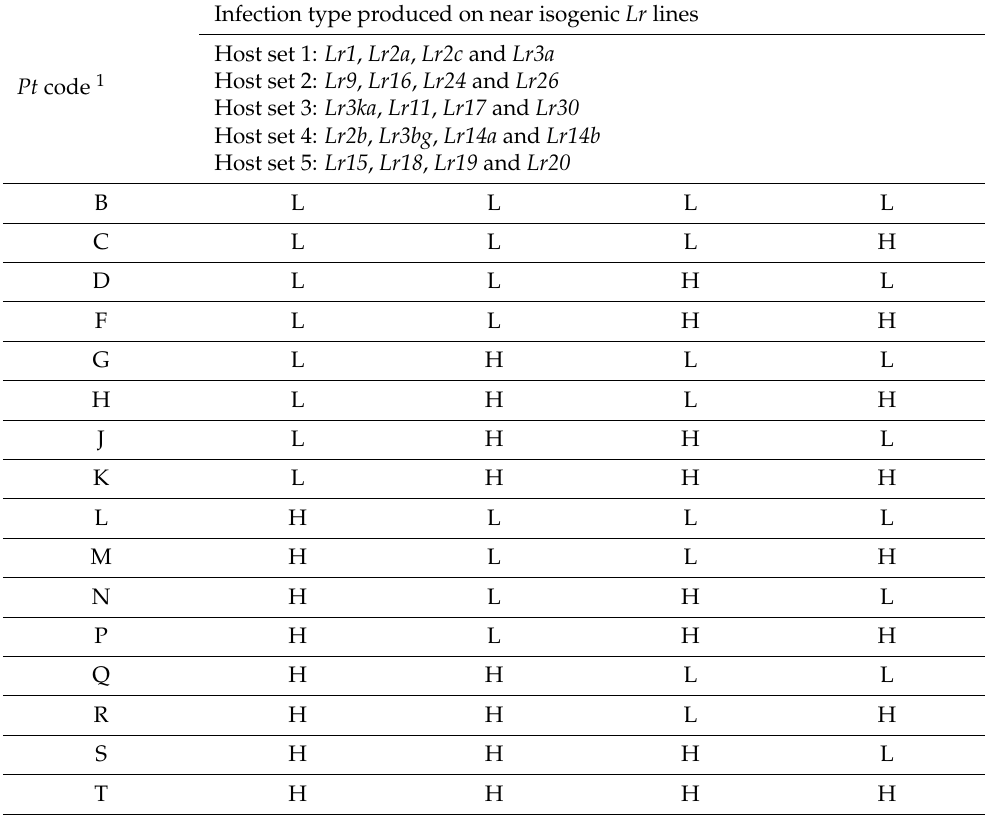
Table 1. Code for the 20 differential hosts for Puccinia triticina ( Pt ). Infection type produced on near isogenic Lr lines Host set 1: Lr1 , Lr2a , Lr2c and Lr3a Host set 2: Lr9 , Lr16 , Lr24 and Pt code 1